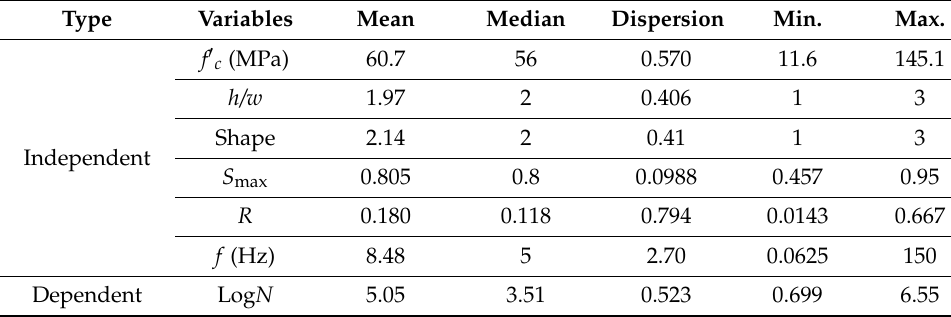
Table 2. Statistical feature of data excluding outliers.